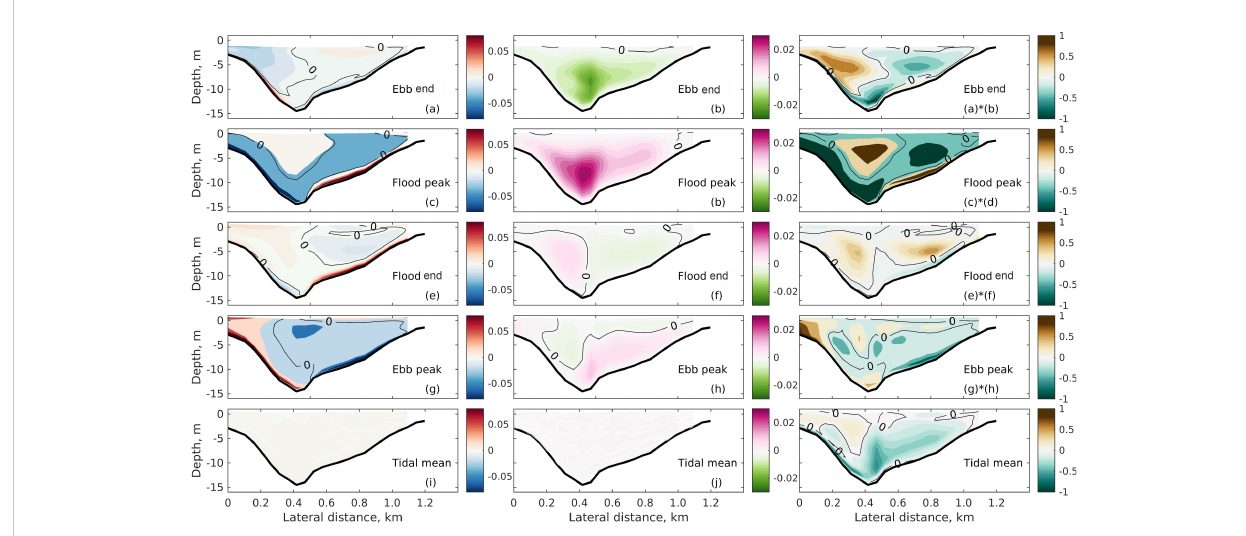
FIGURE 9 Transverse distributions of ( fi rst column) the vertical shear ( ∂ v/ ∂ s , m s − 1 ), (second column) the tidally varying eddy viscosity ( A 0 v ,m 2 s − 1 ) and the